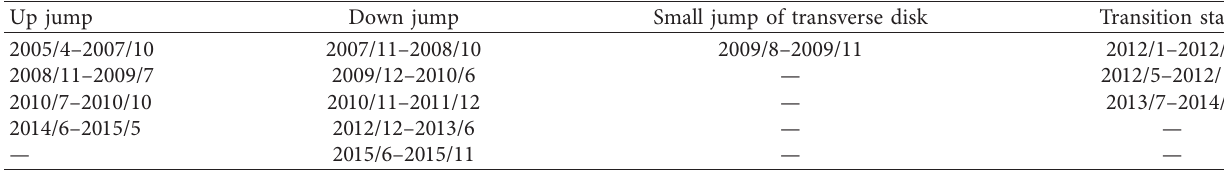
Table 4: Unit root test of price return of metal futures.